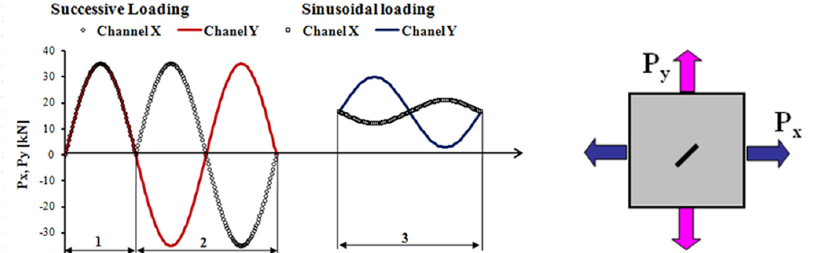
Figure 3: The loads applied to each axis of the load machine for the successive load cycle for crack growth under biaxial load, where  K II /  K I = 2 (1 – mode I loading; 2 – mode II loading), and the sinusoidal load cycle used for data collection, where  K II /  K I = 2 (3 – sinusoidal